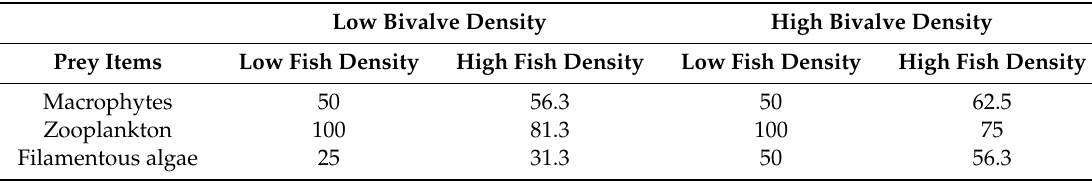
Table 3. Frequency of occurrence (%) of main prey items in the fish diet. Low Bivalve Density High Bivalve Density Prey Items